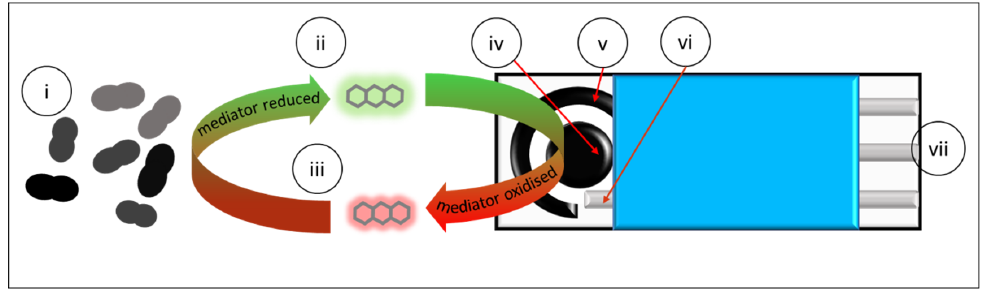
Figure 1. Schematic of LAB detection concept: the LAB (i) reduces a redox mediator (ii) that is released from a specific detection substrate, in this case resorufin- β - D -galactopyranoside (not shown), which is subsequently oxidized (iii) at the working electrode (iv) of a screen-printed electrode 4